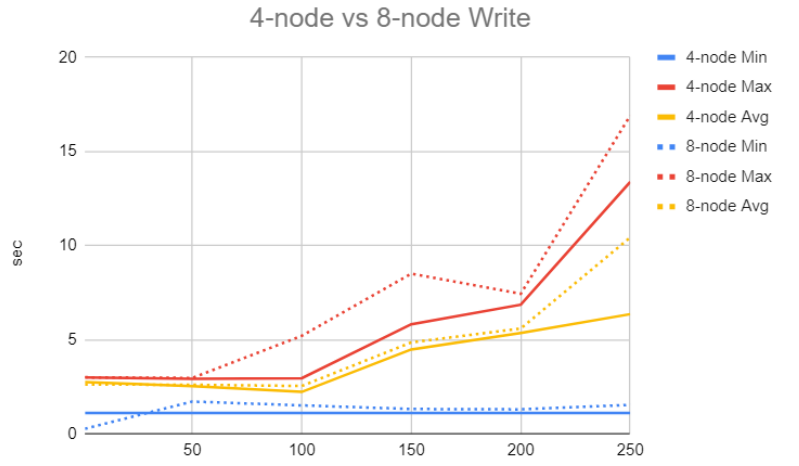
Figure 6. Latency of write TXs (in seconds) measured with different Indy-based BC network sizes and different arrival rates.